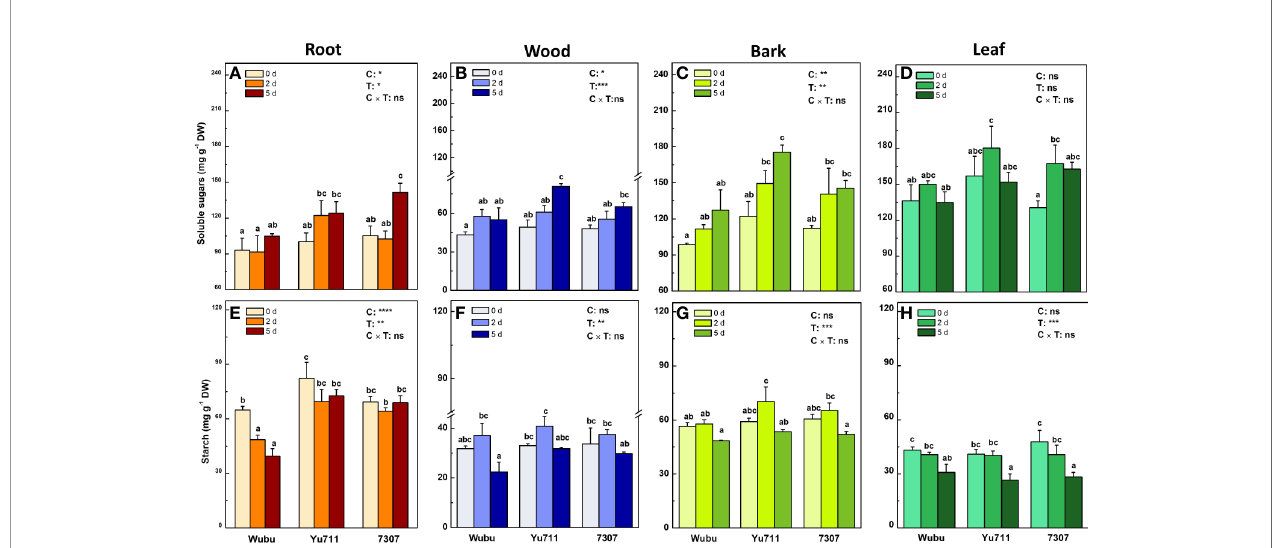
FIGURE 4 | Concentrations of soluble sugars (A – D) and starch (E – H) in roots, wood, bark, and leaves of mulberry cultivar Wubu, Yu711, and 7307 exposed to progressive drought stress for 0, 2, and 5 days (denoted as 0 d, 2 d, and 5 d), respectively. The bar indicates mean ± SE (n = 6). Different letters on the bars indicate signi fi cant difference. ANOVAS of cultivars (C), time (T) and their interaction (C × T) are also indicated. * P < 0.05; ** P < 0.01; *** P < 0.001; **** P < 0.0001; ns, not signi fi